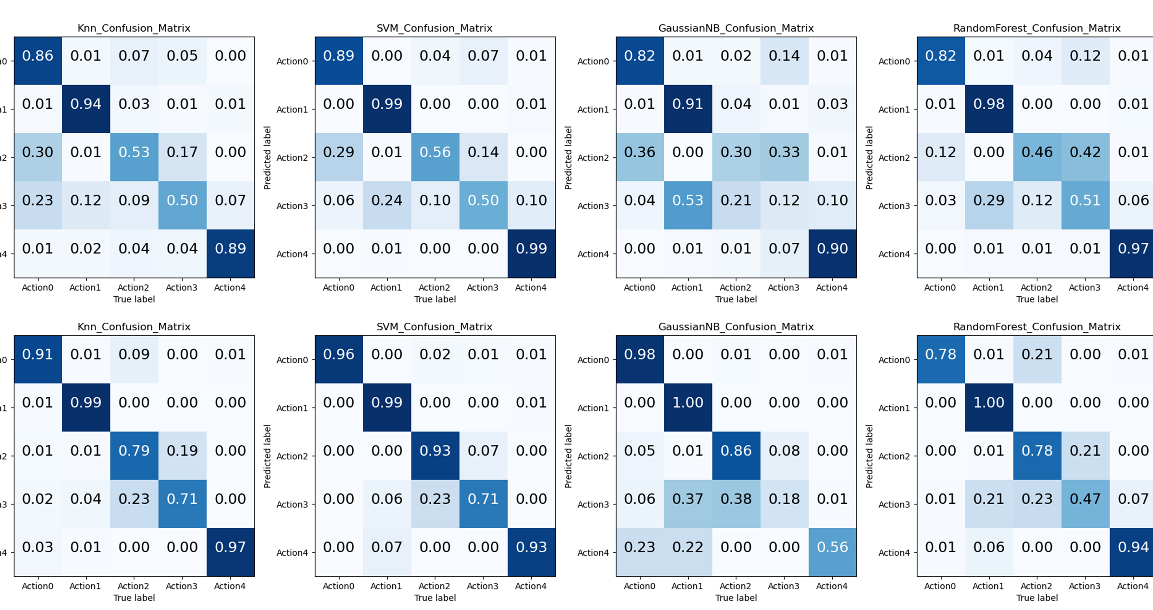
Figure 10. The recognition accuracy of traditional machine learning models based on artificial fea- tures on professional test sets.